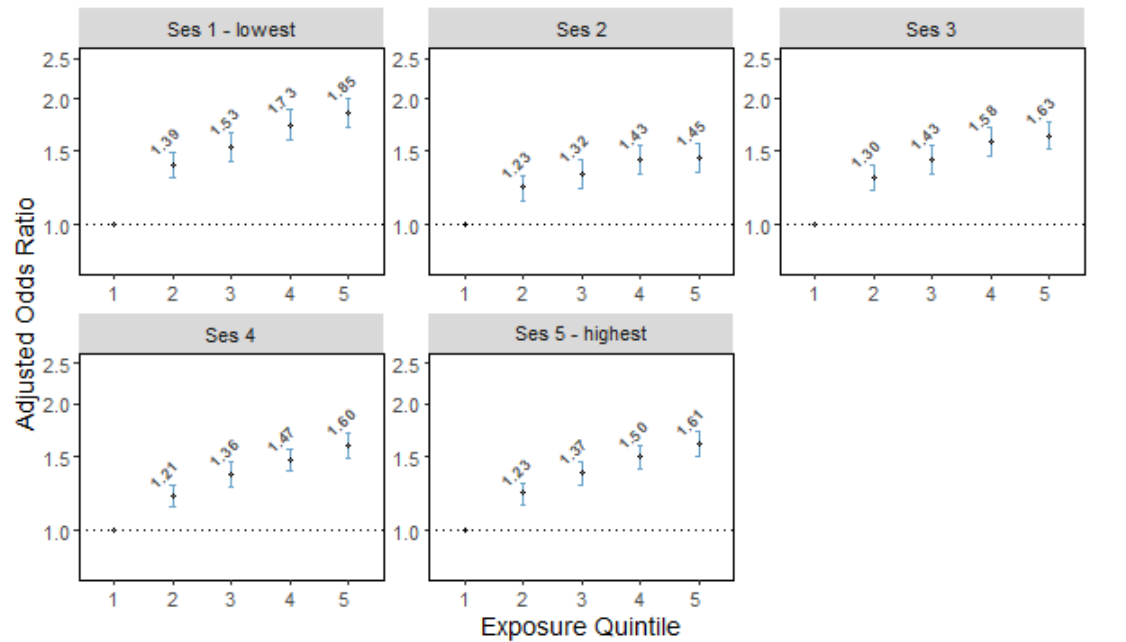
Figure 5. Odds radios and 95% confidence intervals of effect modification by SES for the association between NOx and asthma, adjusted for year of birth and school religious orientation. Higher scores in the census SES index represent higher socioeconomic status. SES 1: n = 471,201, cases = 20,899; SES 2: n = 444,992, cases = 25,514; SES 3: n = 459,409, cases = 29,906; SES 4: n = 464,322, cases = 30,643; SES 5: n = 471,316, cases = 33,204. 1 = lowest NOx exposure category (<5.63 ppb), 2 = (5.63– 10.5 ppb), 3 = (10.5–14.7 ppb), 4 = (14.7–19.1 ppb) and 5 = (19.1–130 ppb).